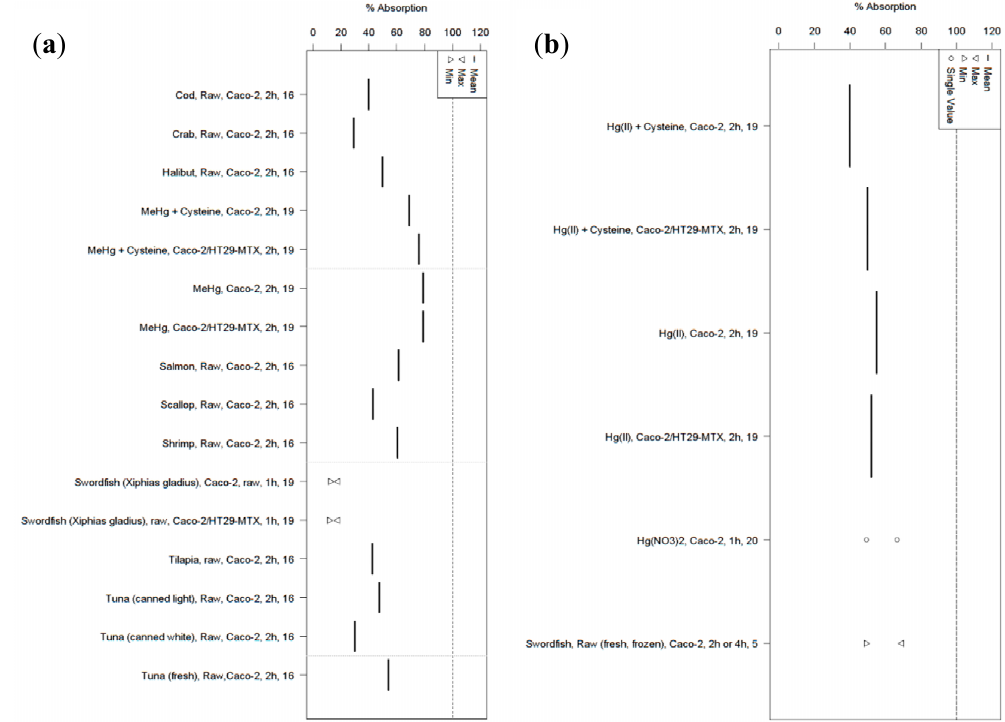
Figure 4. Summary of in vitro studies on absorption of Hg to human intestinal cells from fish consumption for ( a ) MeHg and ( b ) total Hg. In both, each column represents a single species of fish, prepared and/or packaged in a particular way, and introduced to either a monoculture of Caco-2 (intestinal epithelial-like cells) or a co-culture of Caco-2 and HT29-MTX (mucin-producing cells analogous to goblet cells). The numbers along the Y-axis indicate studies, as outlined in Table S4.